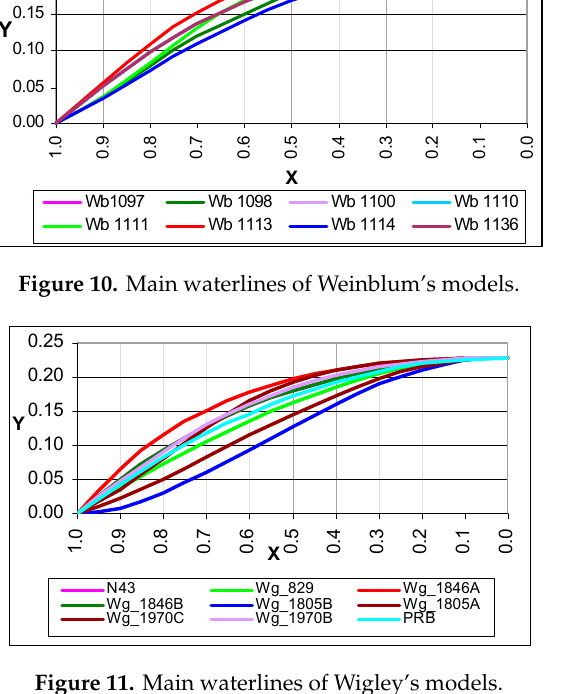
Table 3. Derivatives of the surface equations of the ship hull of Wigley’s models.